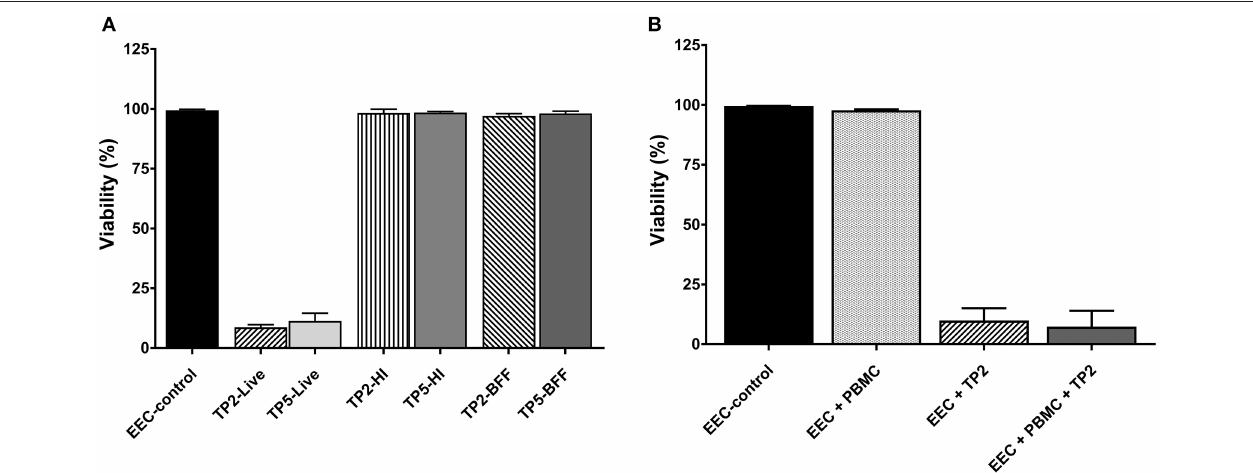
FIGURE 4 | Percentage of viability of endometrial epithelial cells (EEC–control) (A) co-cultured with two strains of T. pyogenes (TP2 or TP5) in the form of live bacteria at MOI = 1 ( − Live), or with heat-inactivated bacteria at MOI equivalent to 1 ( − HI), or with bacteria-free filtrate at MOI equivalent to 1 ( − BFF), and (B) co-cultured with live TP2 at MOI = 1 in the presence or absence of PBMC at a ratio of